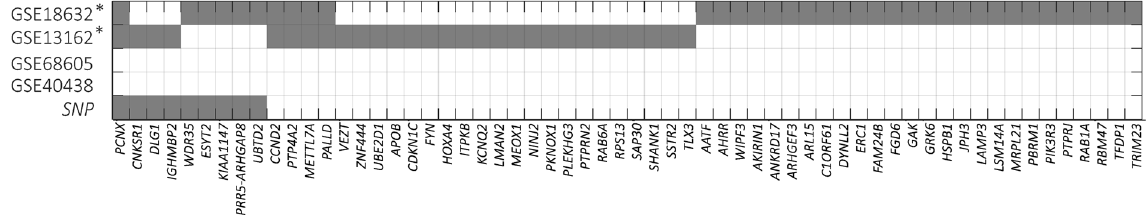
Figure 5. Validated genes by independents gene expression data sets. Significantly differential expressed genes across six independent studies overlaid with the aberrant DNA-methylated genes in FTD-ALS. Grey squares depict overlap of genes between FTD-ALS markers and one or multiple validation data set. Genes that could not be validated were removed from the plot. The SNP row depicts genes that were also discovered with a deleterious